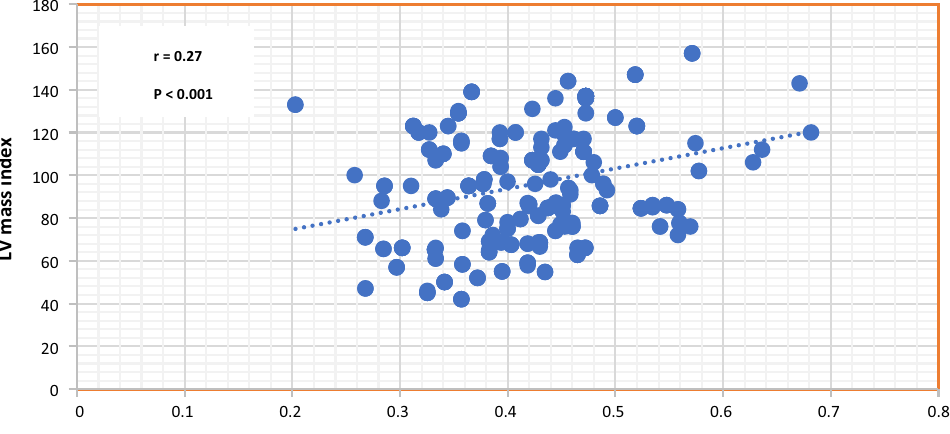
Fig. 6 Correlation between LV mass index and relative wall thickness